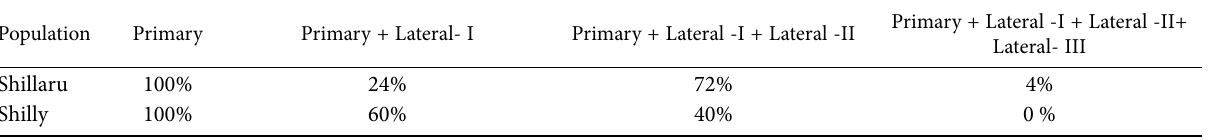
Table 2. Percentage of plants with different umbel order in A. glauca :